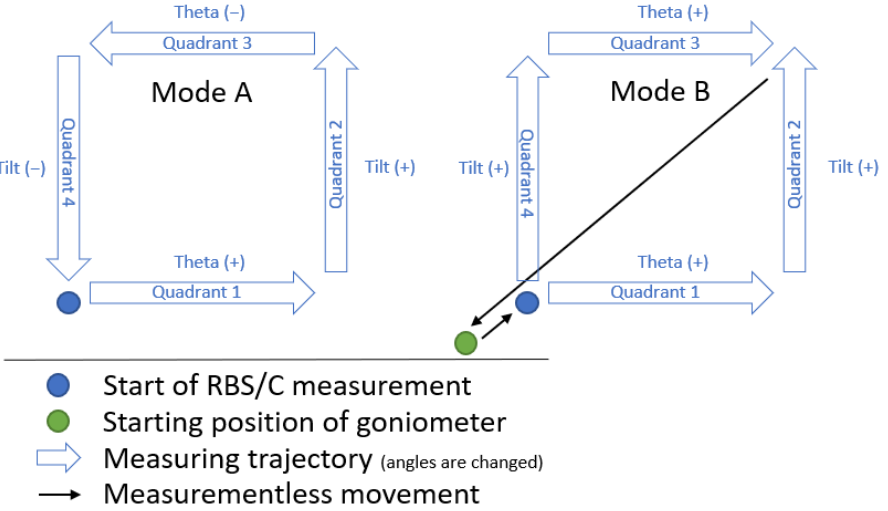
Figure 12. Goniometer and steps generation modes.